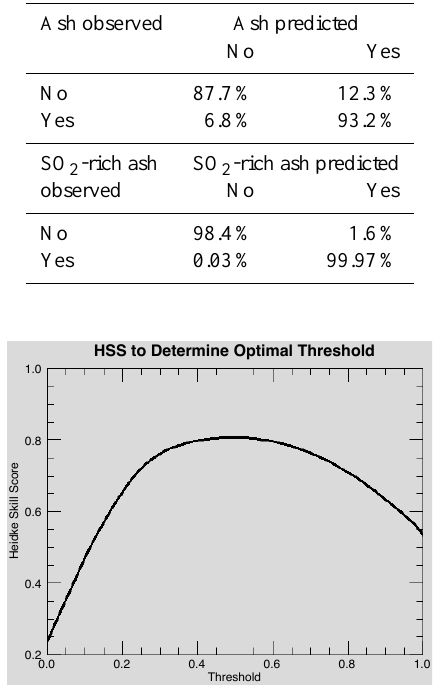
Figure 5. Optimal threshold for ash retrieval determined is 0.48 with Heidke skill score of